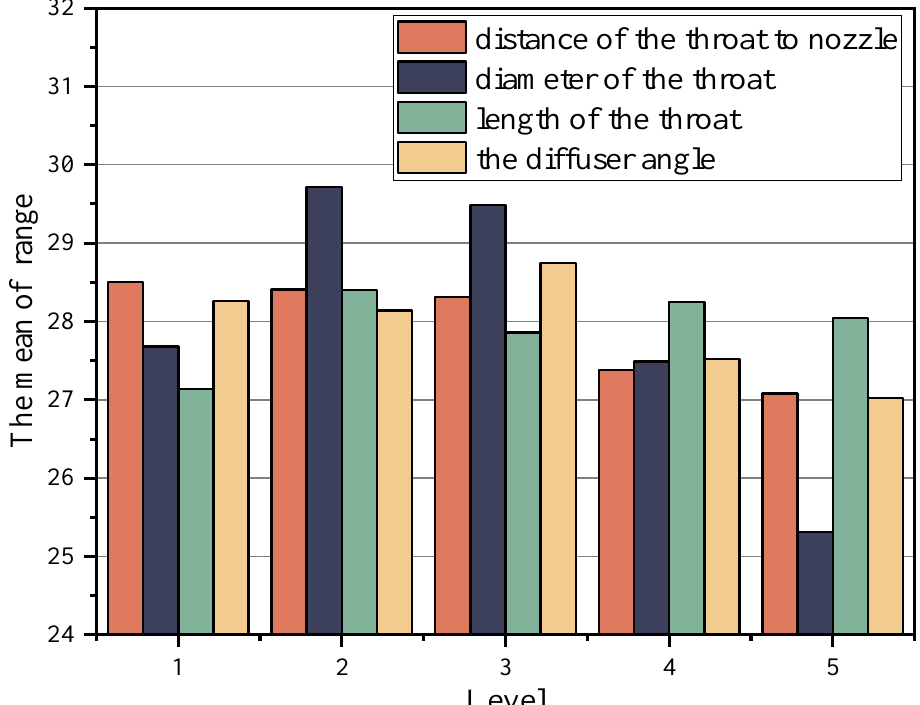
Figure 13. The main effect plot of the mean of the range.